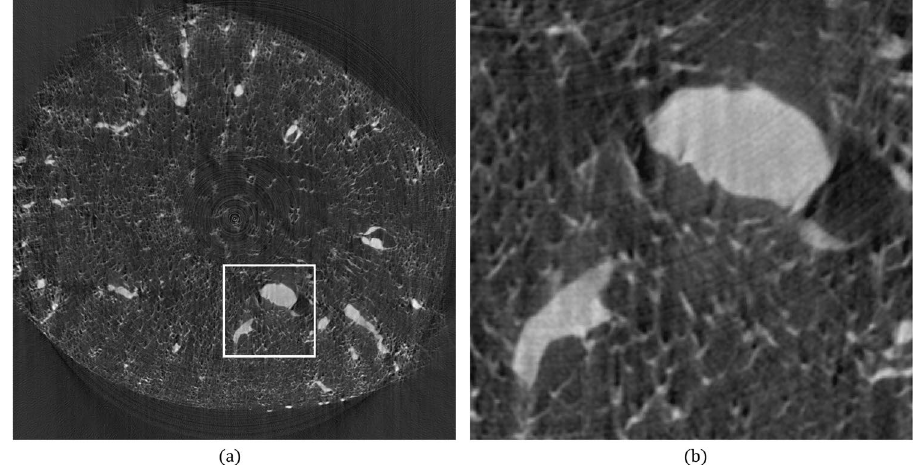
Figure 4. Tomographic images of mouse kidney reconstructed from 601 projections with 1600 parallel beams. The projection angle was configured to be 0.2995° for projection acquisition. ( a ) Reconstruction result without any correction. ( b ) Partial enlargements of the region bounded by the white-bordered rectangle in ( a ).